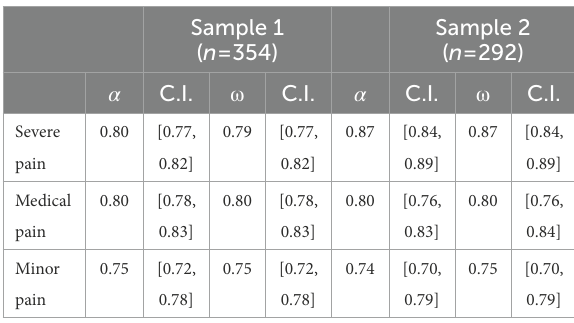
TABLE 9 Internal reliabilities of the two samples.